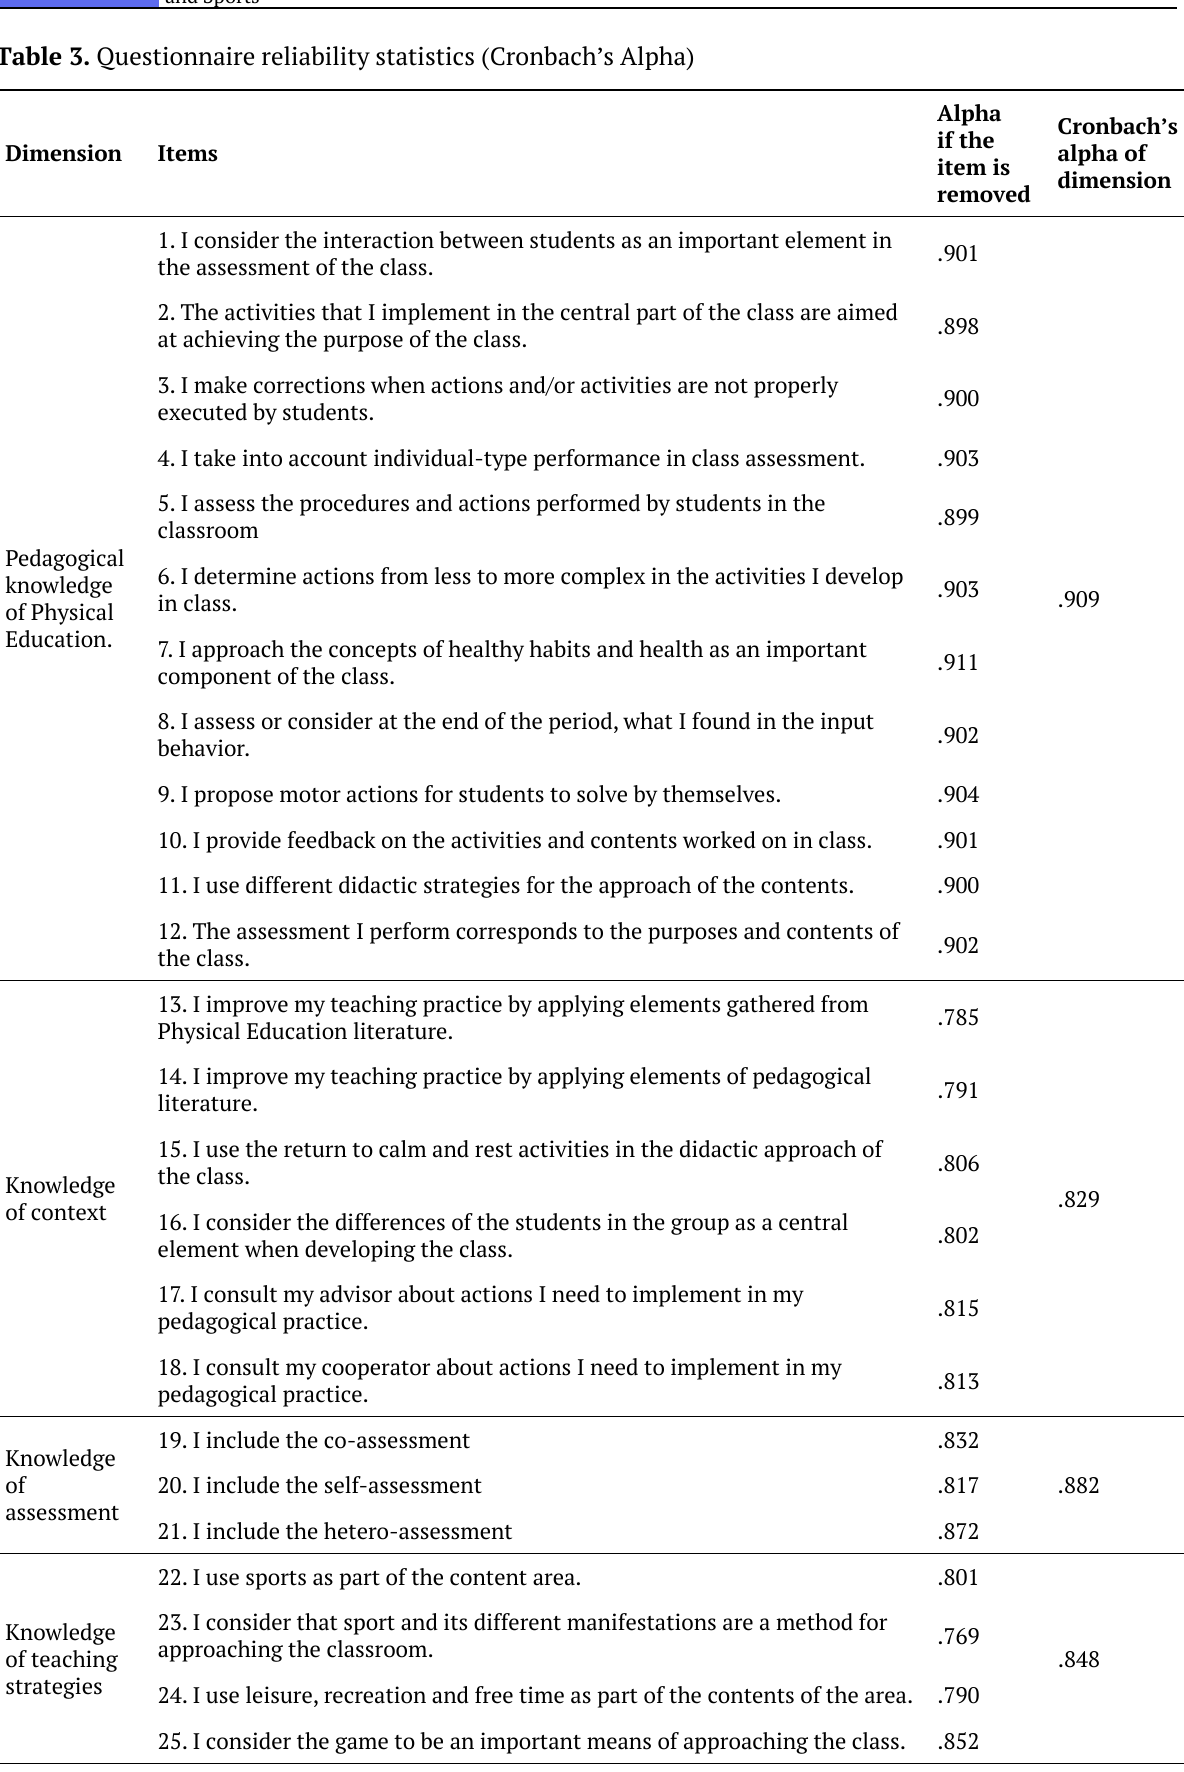
Table 3. Questionnaire reliability statistics (Cronbach’s Alpha)